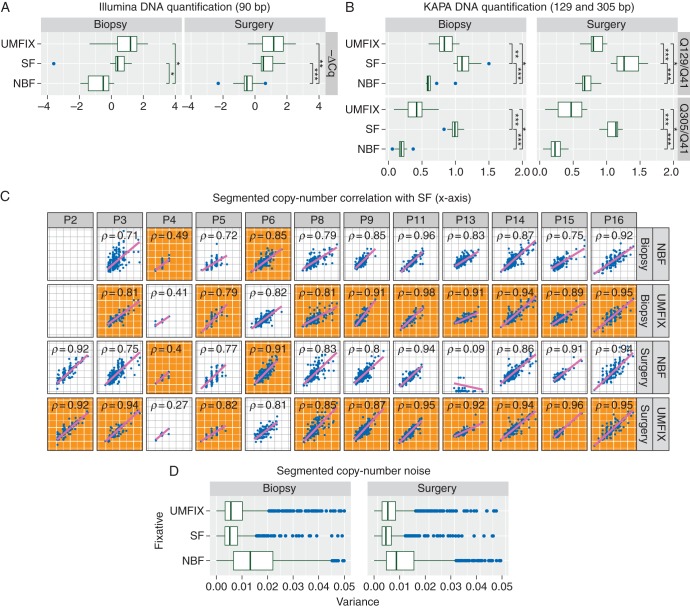
DNA yield and copy-number calling performance. Box plots show results of PCR assays for DNA size after extraction from SF, NBF and methanol (UMFIX) fixation from matched biopsy and surgical samples from 11 HGSOC patients. (A) Observed ΔCq values for DNA yield of 90 bp fragments (negative ΔCq values are shown for convenience). *P < 0.05, **P < 0.005, ***P < 0.0005. (B) Observed Q ratios for 129 bp/41 bp (top) and 305 bp/41 bp (bottom) fragments. Vertical brackets indicate Wilcoxon rank-sum test for difference in means: *P < 0.05, **P < 0.005, ***P < 0.0005. (C) Scatter plots show correlation between median normalised copy-number profiles from shallow WGS of SF compared with NBF or UMFIX biopsy and surgical samples from 12 patients. Spearman's rank-sum correlation rho is shown. Gray background (orange online) indicates plots with the highest correlation between UMFIX and NBF for each patient sample (biopsy or surgery). (D) Boxplots show an observed variance for each copy-number segment (n = 90 312) in 69 samples from 12 patients.